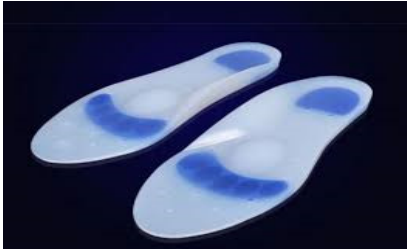
Figure 4. 4 mm polypropylene insole PP-DWST.